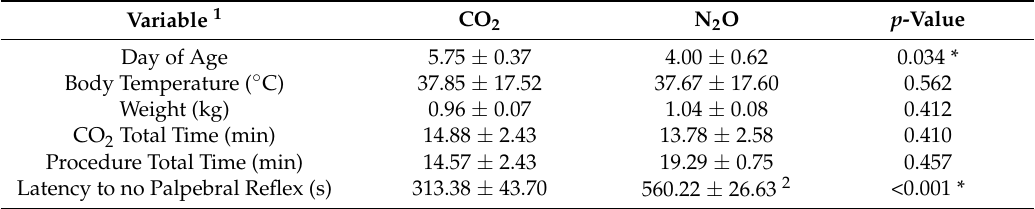
Table 2. Data collected (mean ± SE) on individual pigs for the two treatments during Experiment 1.